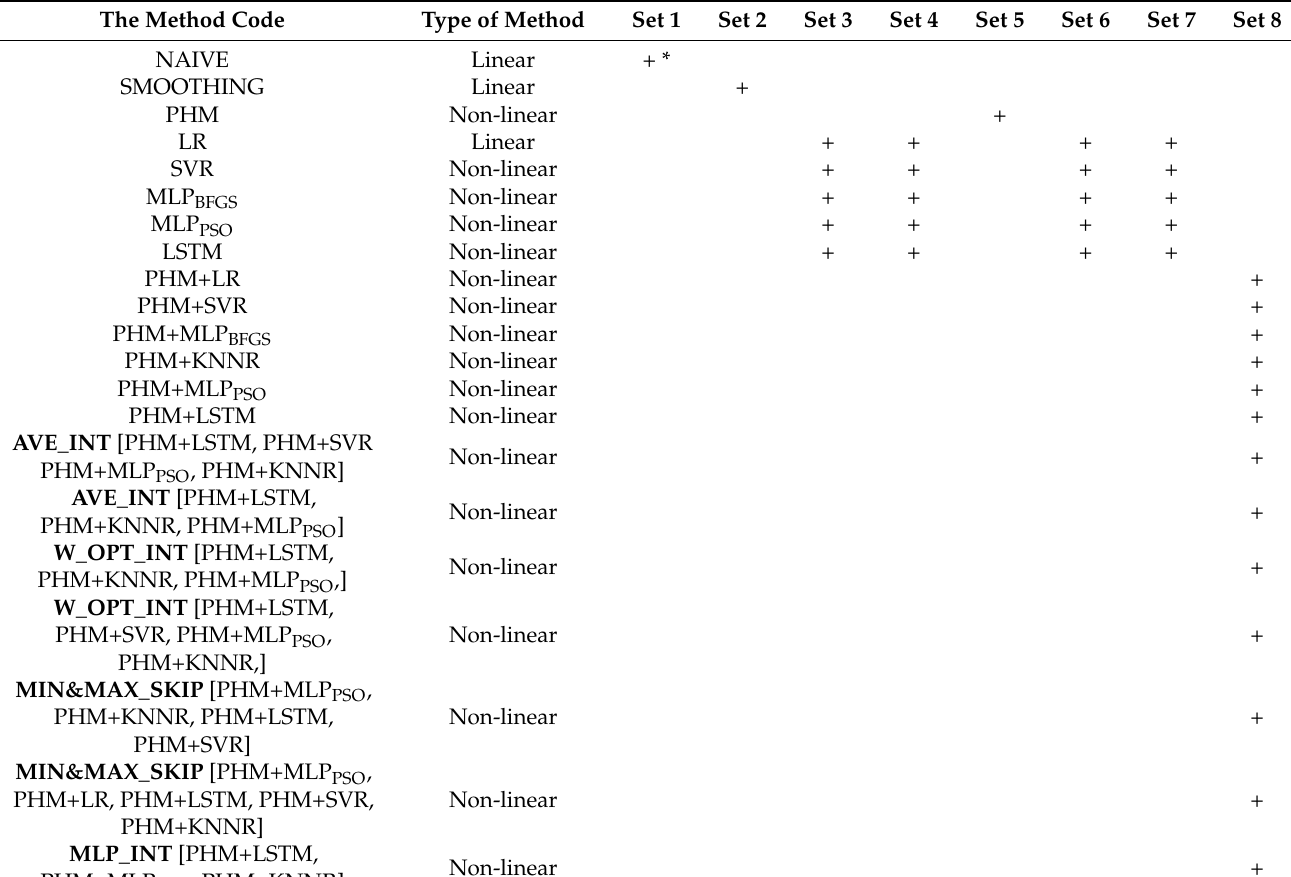
Table 5. Tested input data sets for each